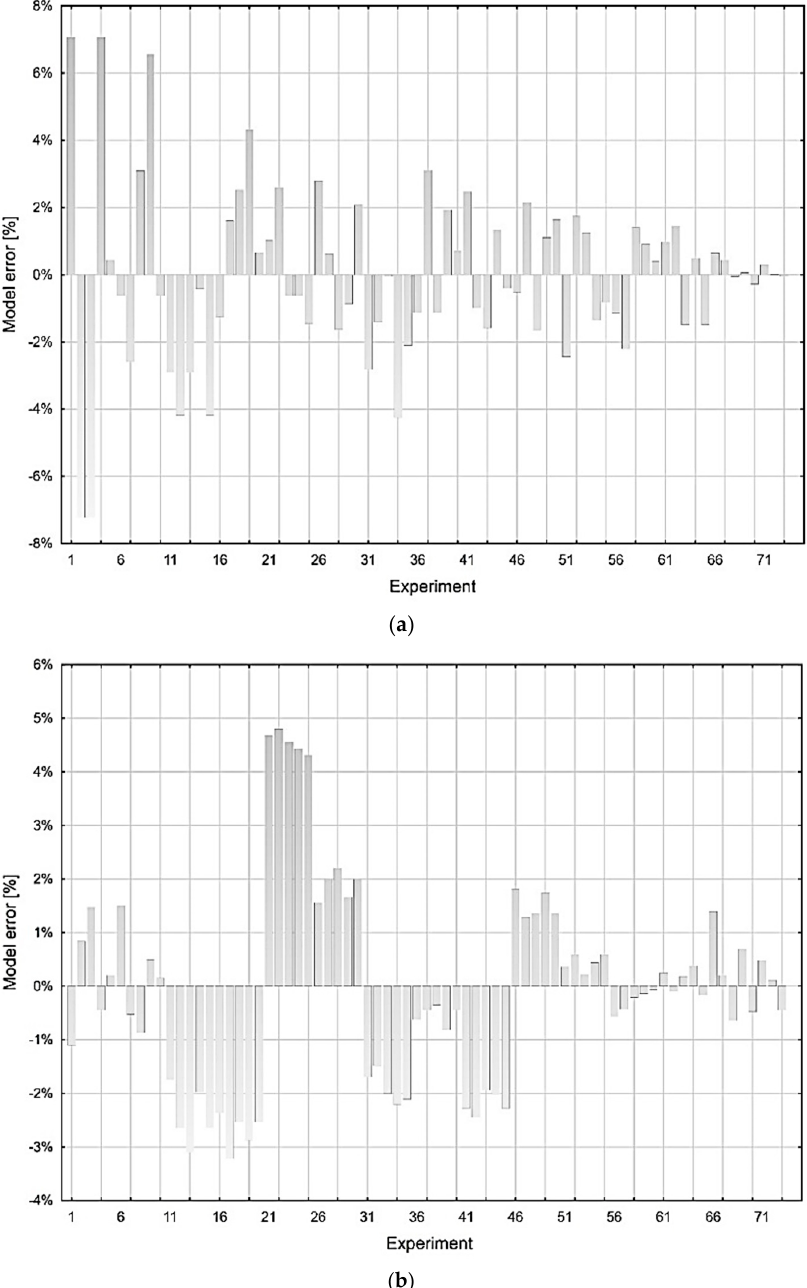
Figure 5. Graphical analysis of the predictive MSC models. ( a ) MSC model deviations for MRR . ( b ) MSC model deviations for Rz .